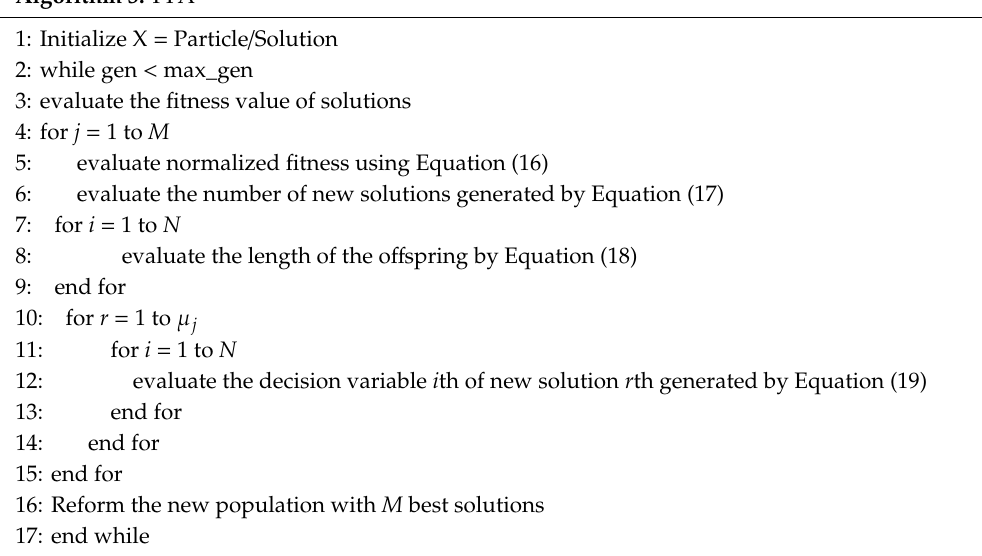
Algorithm 3. PPA